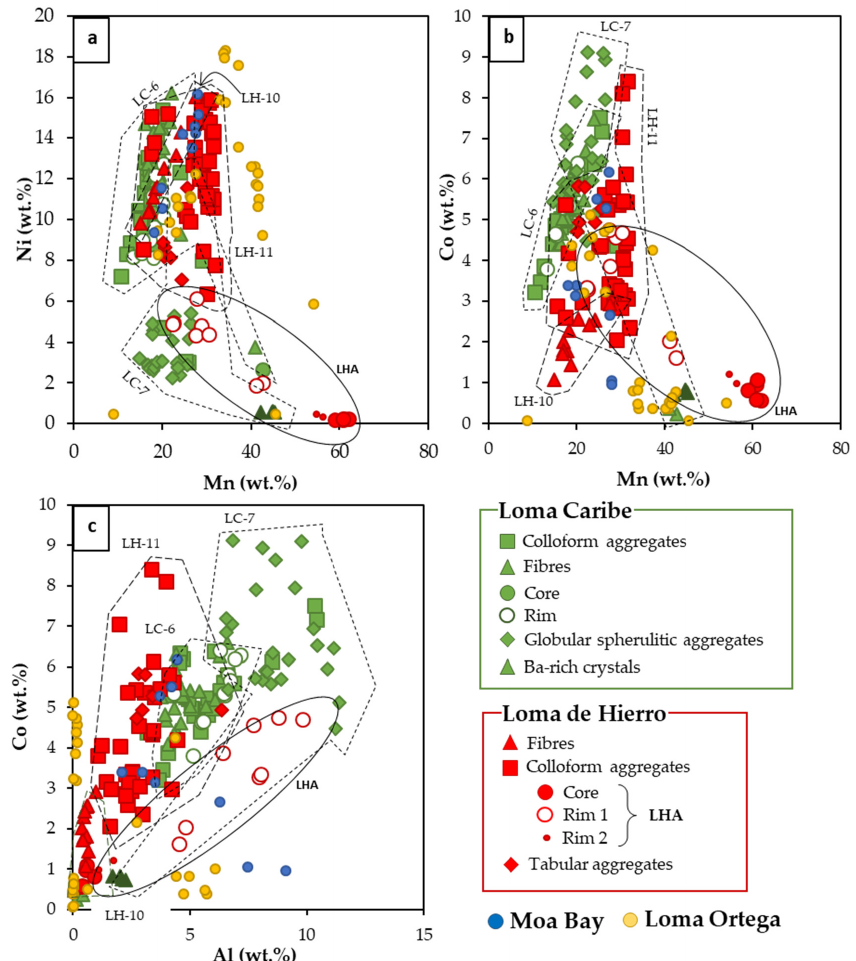
Figure 11. Binary diagrams of ( a ) Ni vs. Mn, ( b ) Co vs. Mn, and ( c ) Co vs. Al (in wt.%), of the Mn–Co minerals analysed in this study, and from Loma Ortega [46] and Moa Bay [47].